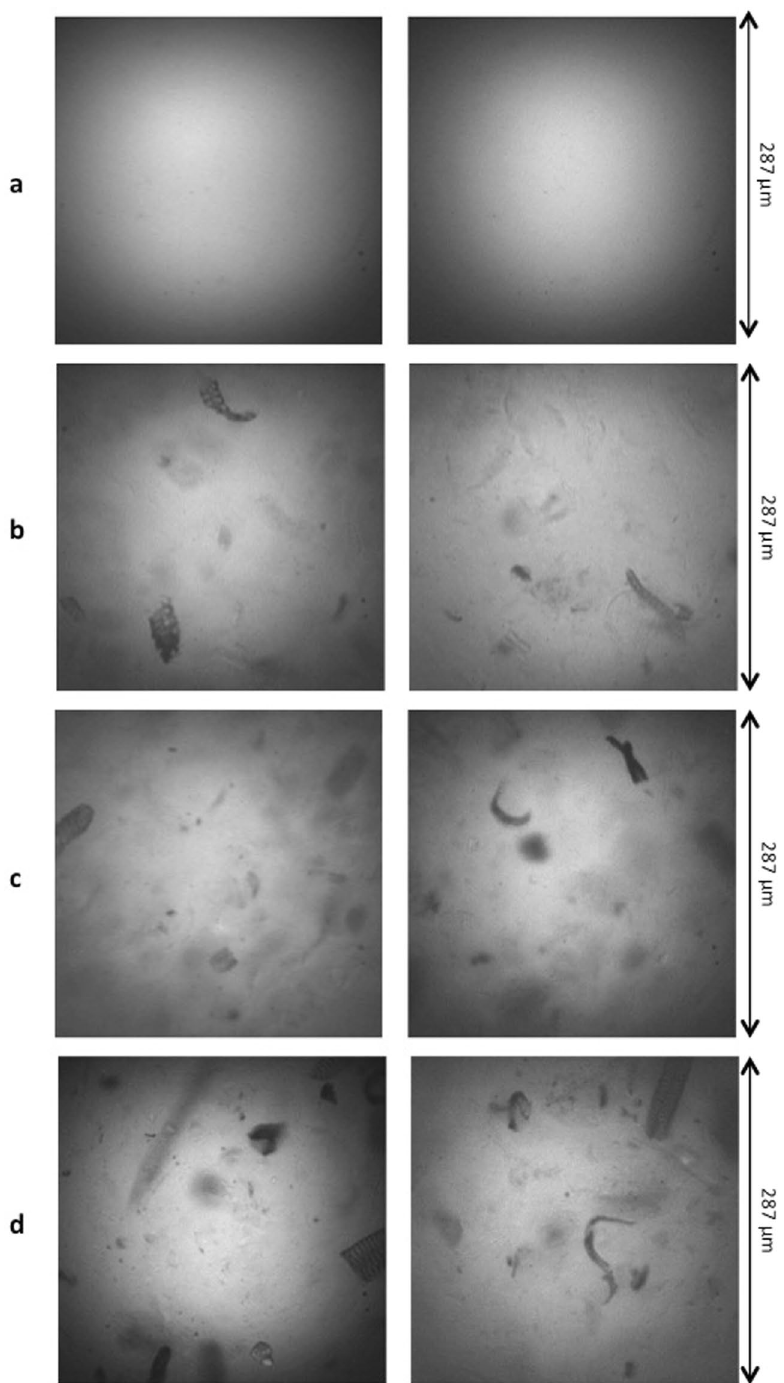
Figure 3. Raw fluorescence images of Pos0 at time T0 of two kinetics carried out on each gel type: ( a ), 0% cellulose; ( b ), 0.5% cellulose; ( c ), 1.0% cellulose; ( d ), 1.5% cellulose. To allow comparison, brightness and contrast were similarly adjusted for all images. The full field of view was 287 × 287 µ m 2